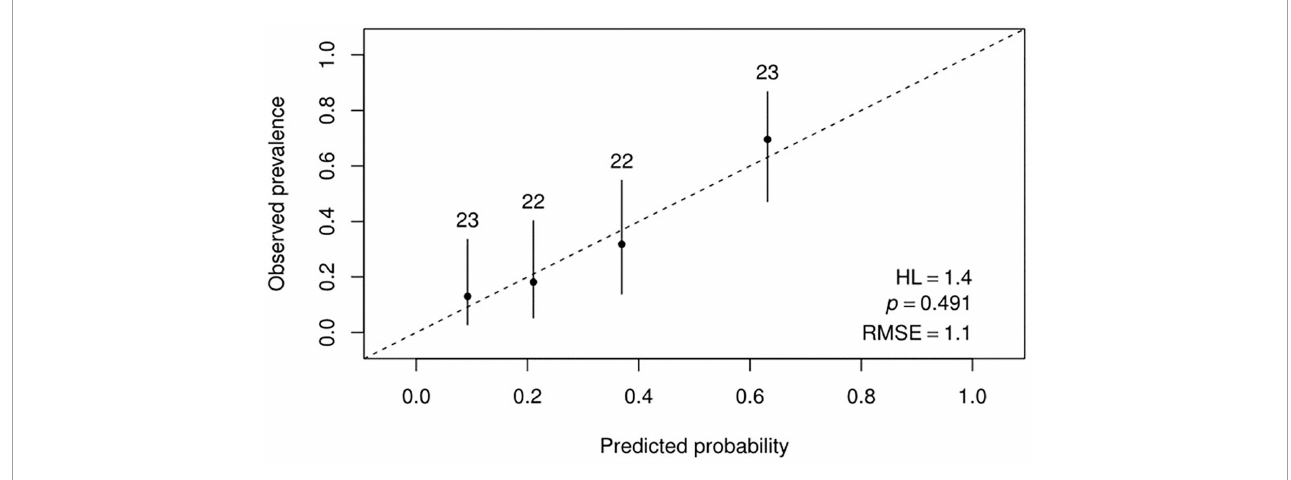
FIGURE4 Calibration plot reporting the observed probabilities against the model predicted probabilities.